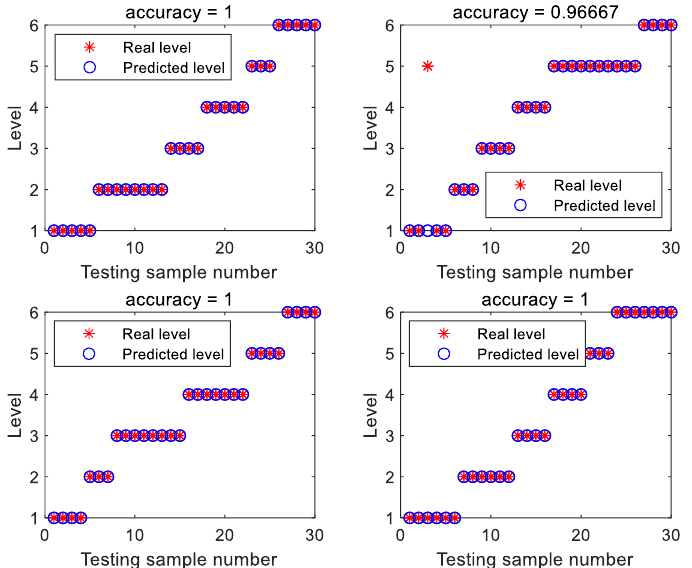
Figure 5. Detailed testing results obtained using the CLPSO-SVM model, with the PC number being 16.